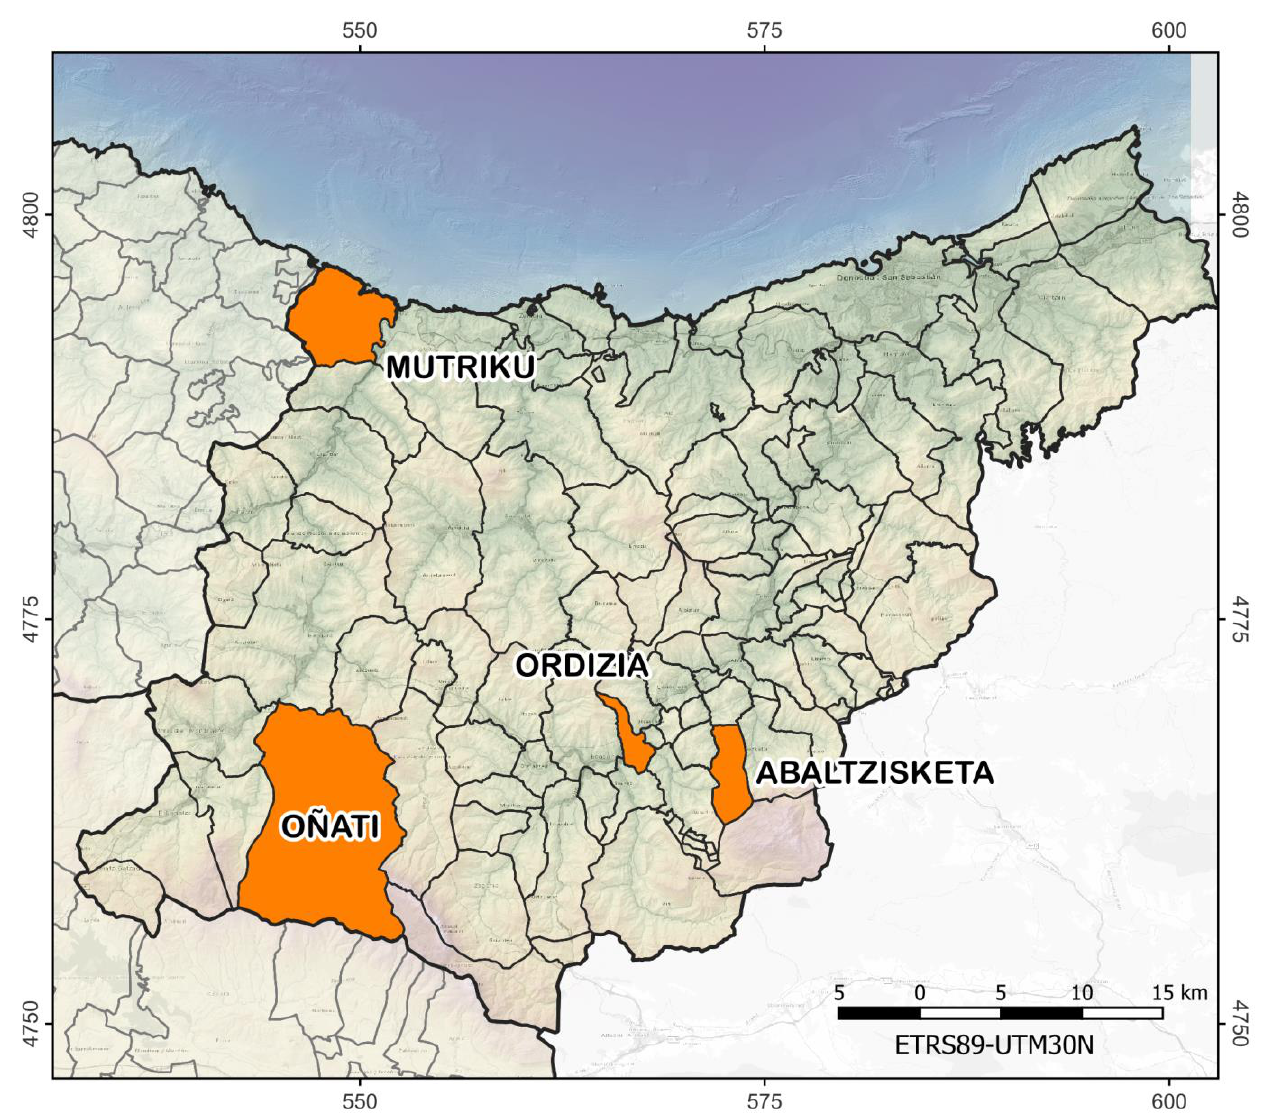
Figure 3. Location map of the sample municipalities. Frame coordinates in km.